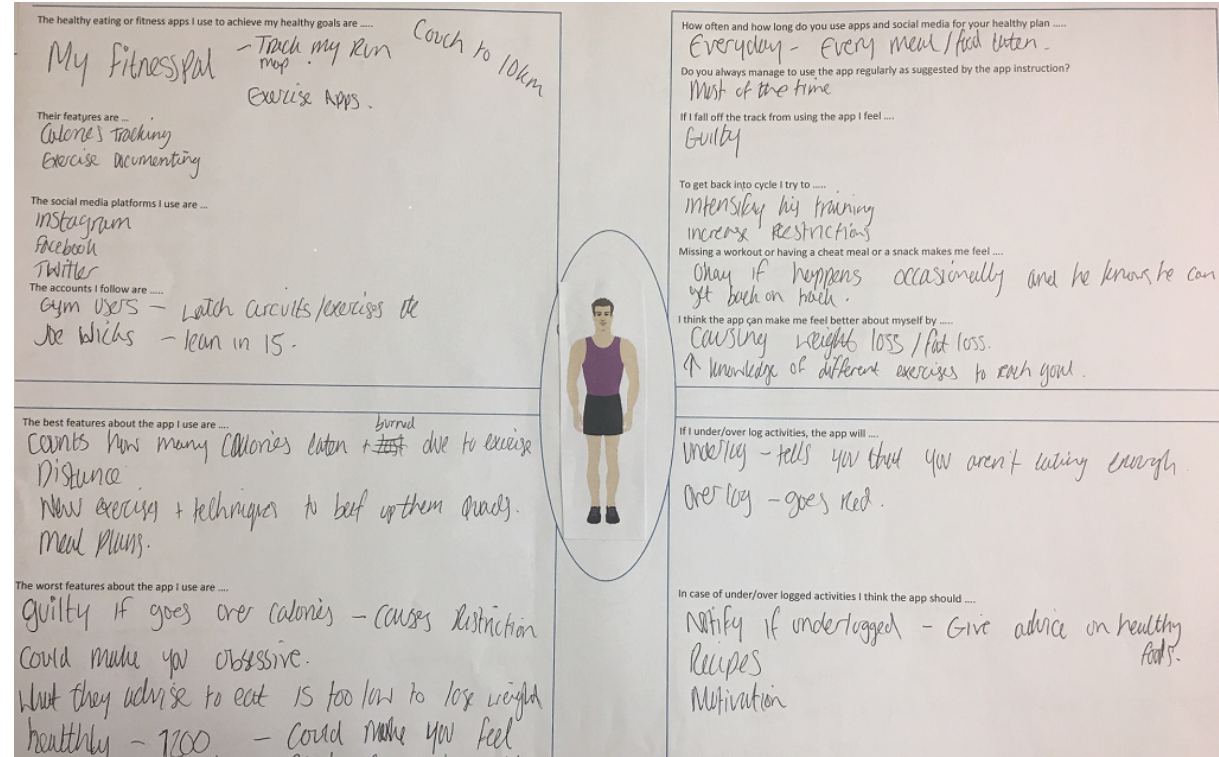
Figure 1. Example of persona